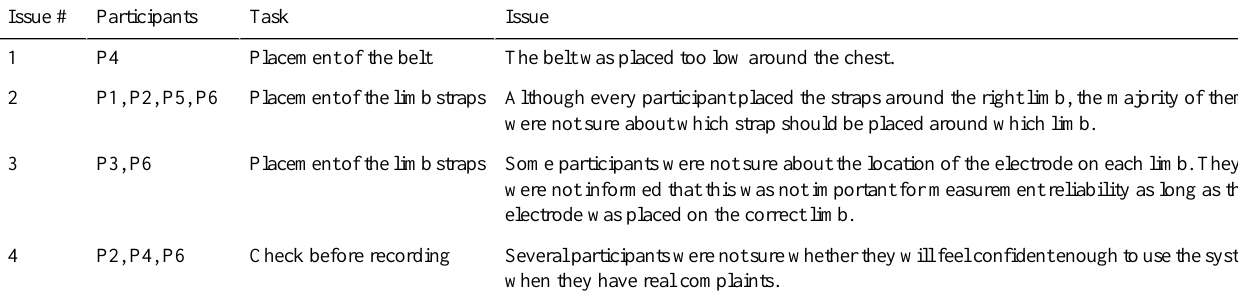
Table 1. Major issues identified during the usability